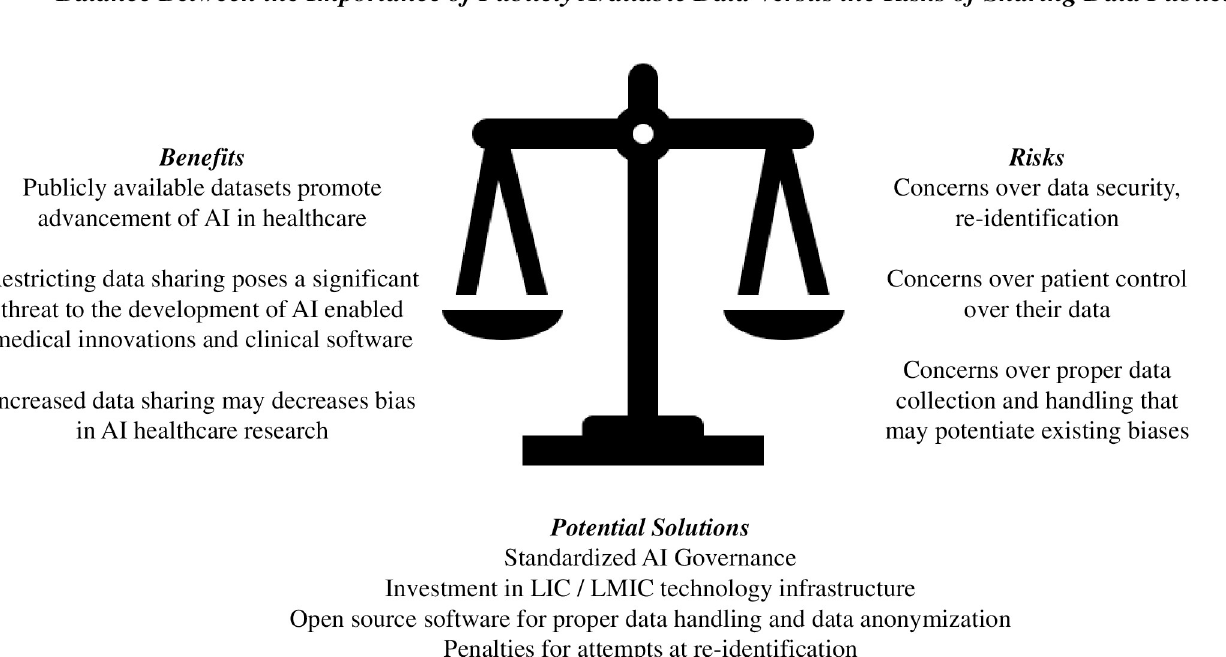
Fig 1. The balance between the importance of publicly available data versus the risks of sharing data publicly. Potential solutions are presented. AI, artificial intelligence; LIC, low-income country; LMIC, low-middle-income country.